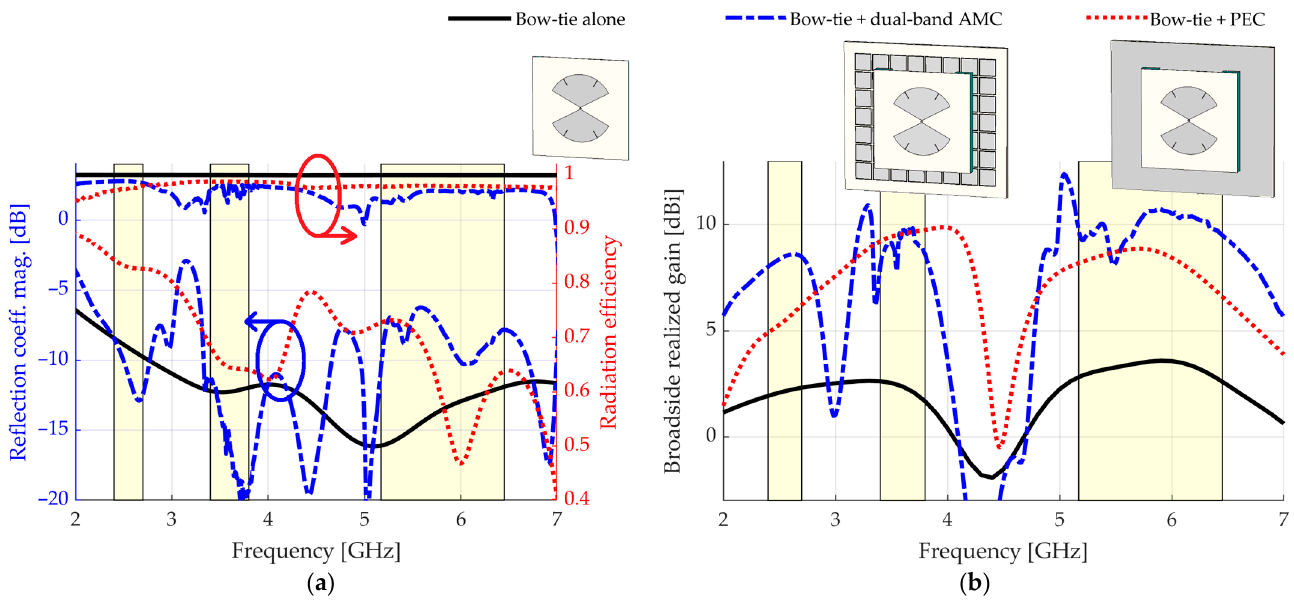
Figure 13. Simulated results for the standalone antenna, the antenna backed by the dual-band AMC, and the antenna backed by a PEC reflector: ( a ) reflection coefficient magnitude and radiation efficiency; ( b ) broadside realized gain.